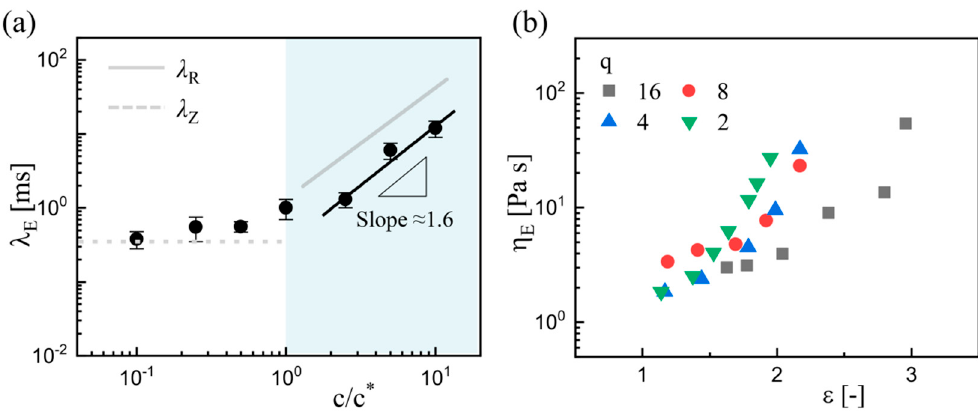
Figure 9. Results of extensional relaxation time λ E and extensional viscosity η E . ( a ) Variation of extensional relaxation time values λ E with PEO concentrations. The grey line represents the predicted values for reptation time λ R , and the grey dashed line represents the predicted values for the Zimm relaxation time λ Z . ( b ) Evolution of extensional viscosity η E with Hencky strain ε at c = 5 c * .